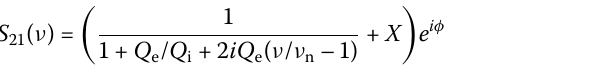
complex transmission